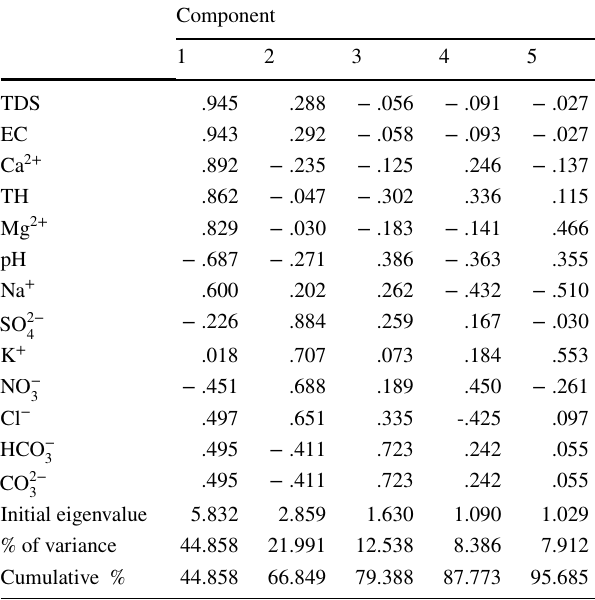
Table 6 Factor loading and eigenvalues of extracted components dur- ing dry season Component